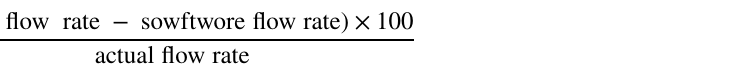
Fig. 4 Free and submersible flow (left and right, respec- tively) in trapezoidal